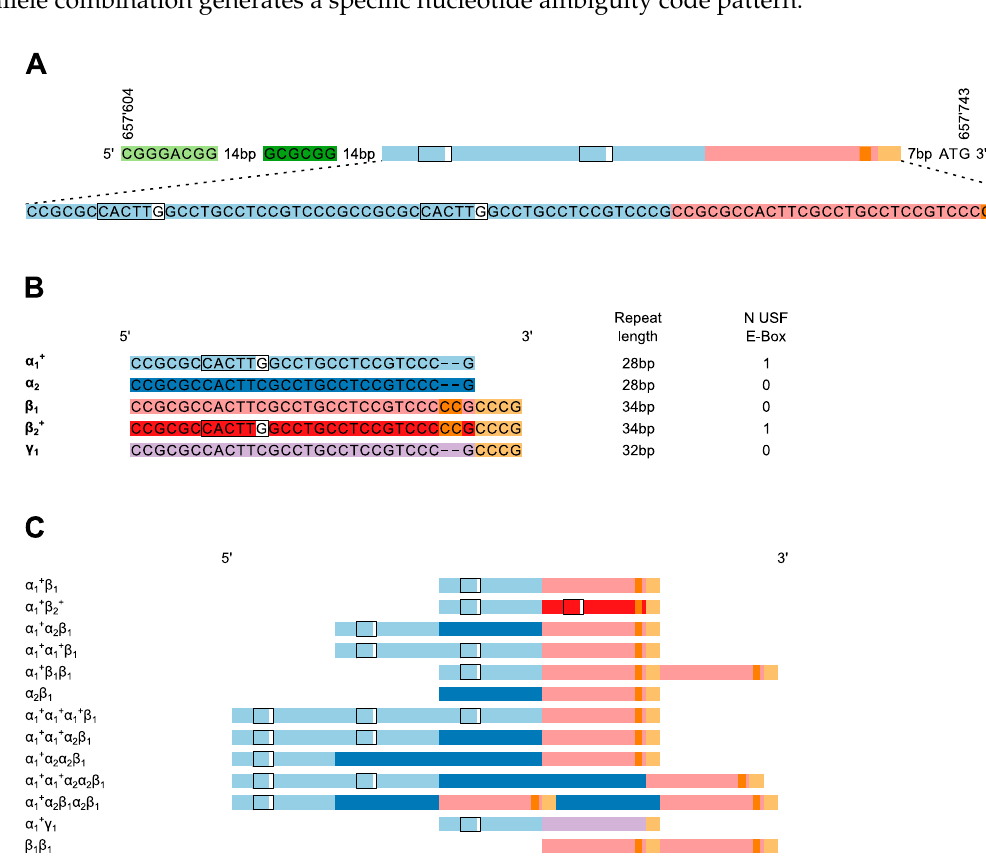
Figure 1. The reference and observed structures of the TYMS TSER-region. ( A ) The reference structure of the TSER (NC_000018.10:657’604.657’743) consists of three imperfect repeats. Upstream of the repeats, an inverted repeat is indicated in light and dark green. The region was PCR-amplified using the forward primer 5’-GTG-GCT-CCT-GCG-TTT-CCC-CC-3’ (position 657543; 200bp upstream of the start codon in the NC_000018.10 reference) and the reverse primer 5’-GCT-CCG-AGC-CGG-CCA-CAG-GCA-TG-3’ (including the start codon at the 3’-end indicated in bold) ( B ) Shown here are five variants of the imperfect tandem repeats together with the length of each repeat that were observed in 1258 sequenced TYMS -promoter region alleles. The presence of the USF1-binding E-box is indicated as a box for each of the five repeats. ( C ) Shown here are the 13 different TSER-alleles observed in 629 sequenced patients with the corresponding new